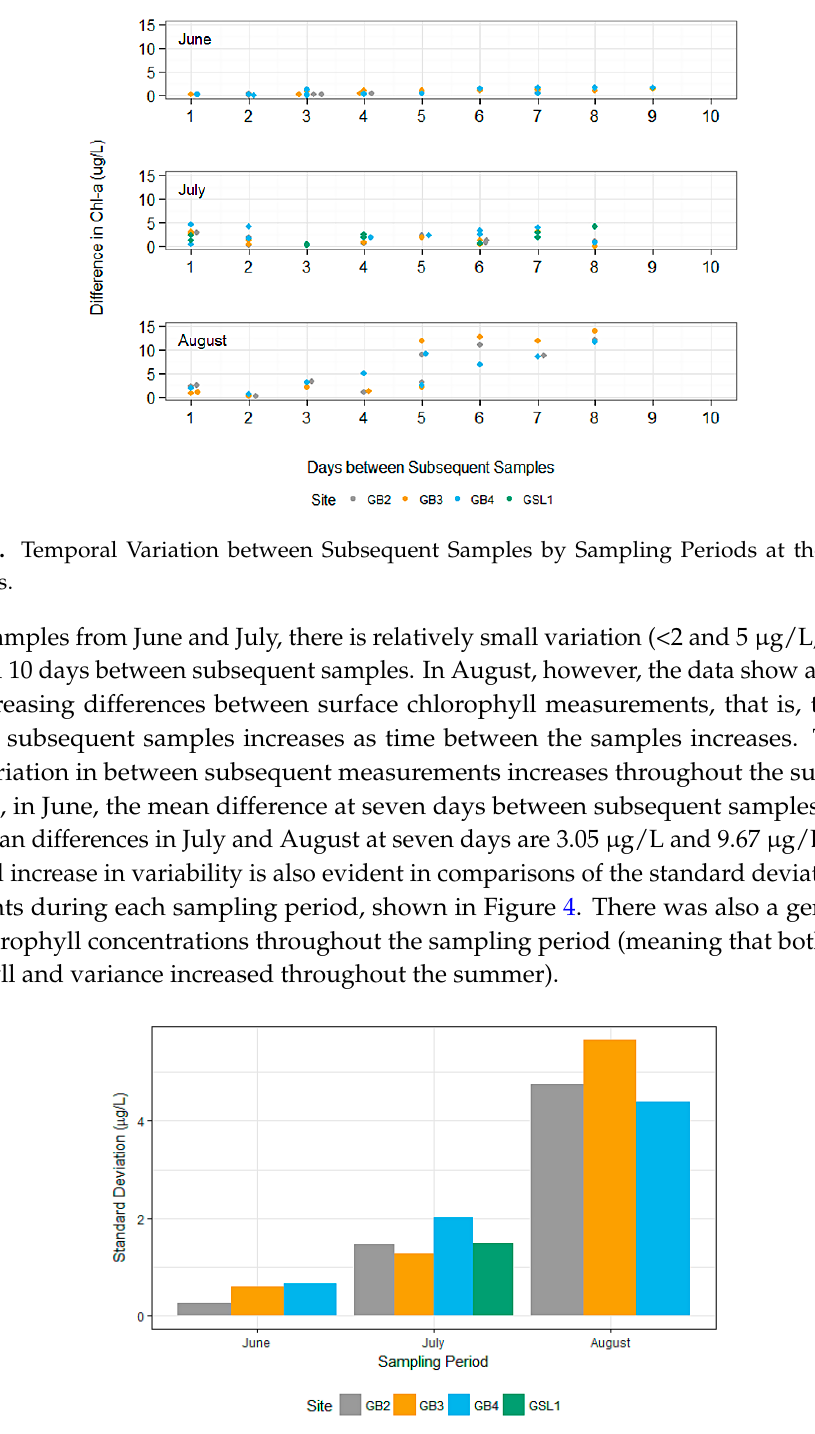
Figure 4. Standard Deviation for Surface Chlorophyll at GB and GSL Sites by Sampling Period.